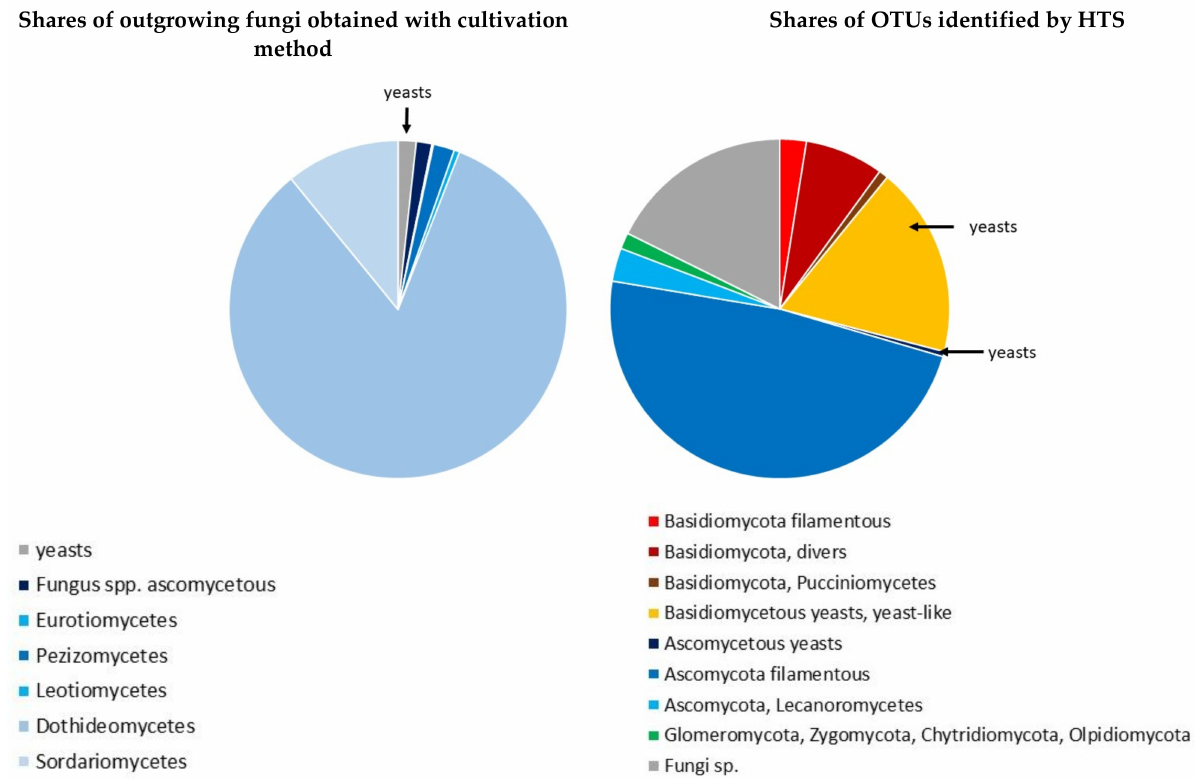
Figure 4. ( left ): Proportions of outgrowing fungi obtained by the cultivation method: ( right ): Proportions of OTUs identified by